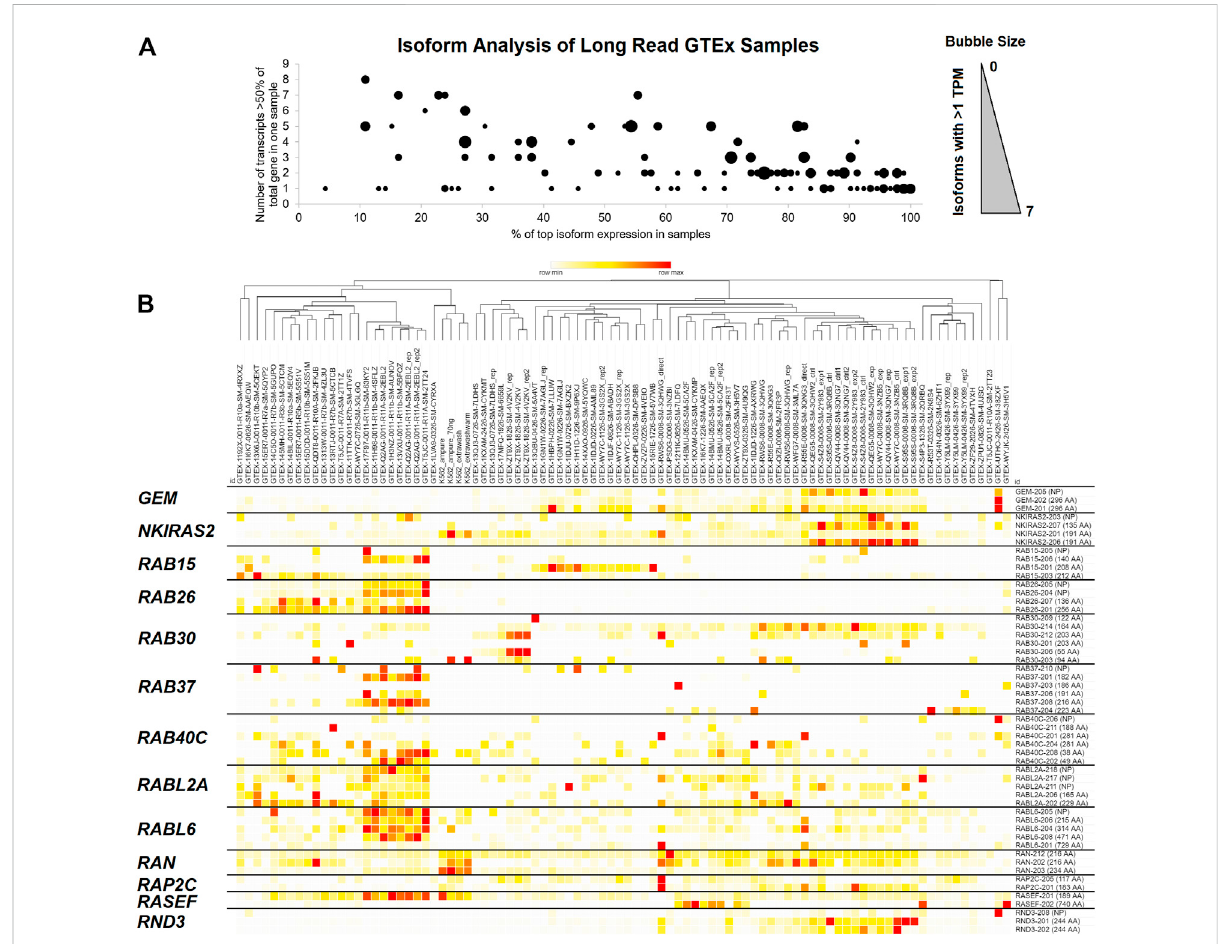
FIGURE 2 GTEx long-read sequencing data for small GTPase isoforms. (A) Analysis of the small GTPase genes for protein-coding isoform expression in Nanopore-based long-read sequencing, where each spot corresponds to one small GTPase gene. The x -axis shows each gene ’ s average % expression of the top expressed isoform. The y -axis shows the number of transcripts greater than 50% of a gene expression in any sample. The dot size corresponds to the number of protein-coding isoforms within a gene with an average greater than one transcript per million sequences (TPM). Values with zero are not shown, and the maximum number of isoforms is seven within one gene. (B) Heat map of Nanopore-based long read samples of GTEx for several genes that have expressed multiple isoforms. The top shows each Nanopore sample listed as a column with a dendrogram generated as one minus Spearman ’ s rank correlation.The rightshows isoformsfor each row. Coloring is based on thez-score for each gene across all samples, with the middle level in yellow and the highest in